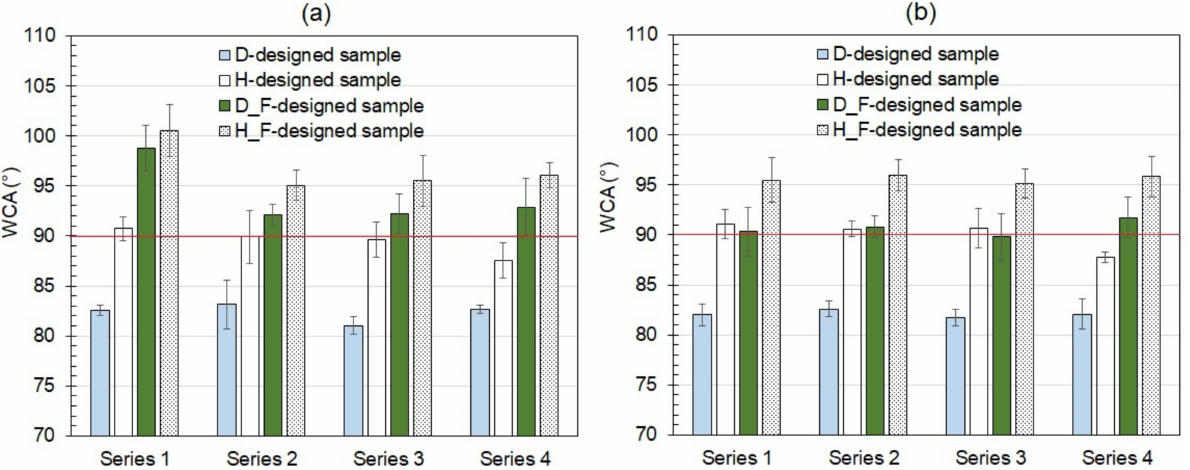
Figure 5. Wettability of coatings expressed in terms of water contact angle: ( a ) before exposure to distilled water; ( b ) after 1-day-long exposure to distilled